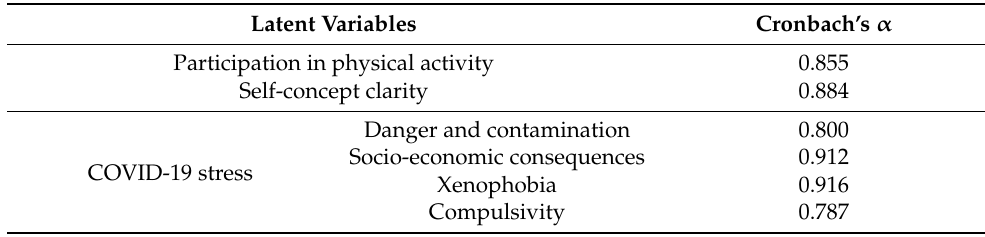
Table 5. Analysis of